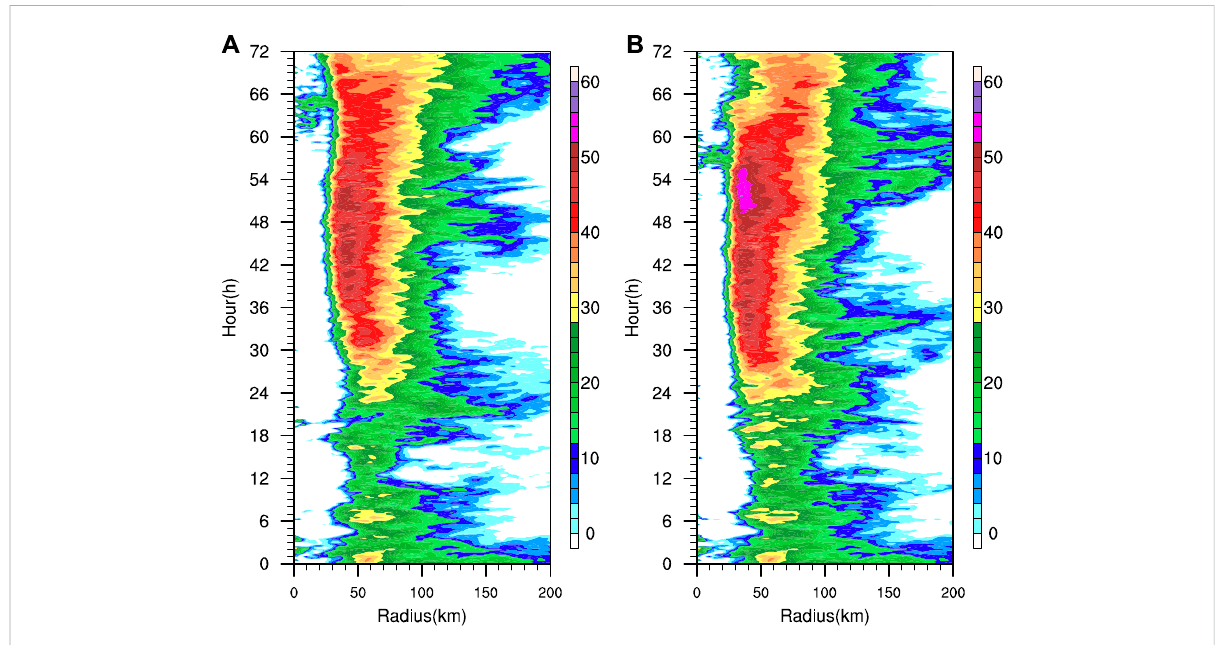
Radius-time pro fi les of the radar echo at 1 km altitude in the (A) control and (B) sensitivity experiments.